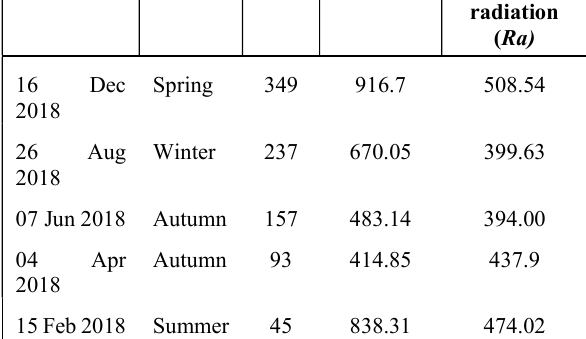
Table 1. Satellite Landsat 8 OLI/TIRS data and meteorological